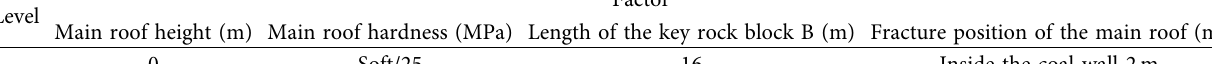
Table 1: Experimental factors and